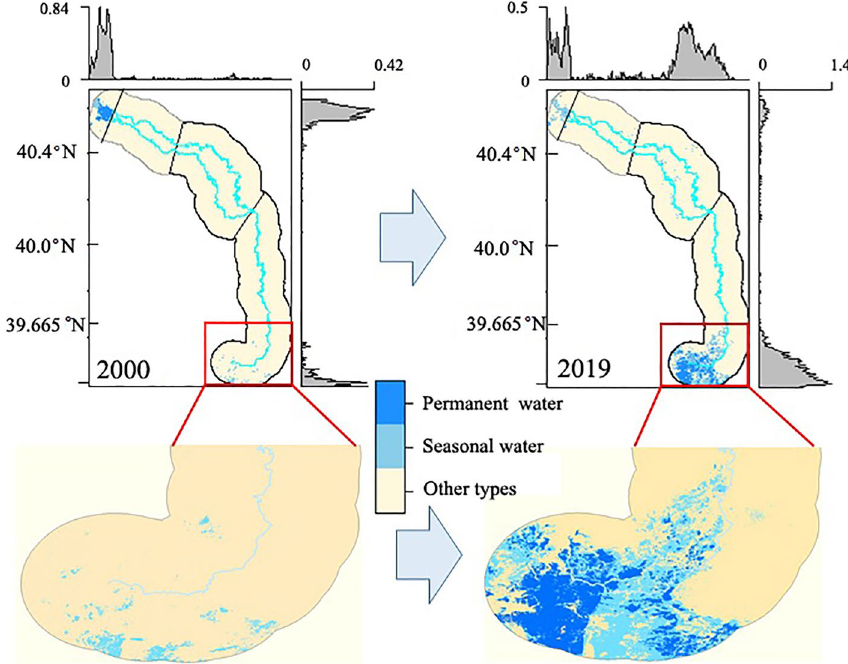
Figure 2. Spatial distribution of water surface area in lower reaches of Tarim River in 2000 and 2019. The subfigures were generated in R 4.0.2 (https:// cran.r- proje ct. org/ bin/ windo ws/), and then merged in Microsoft PowerPoint 2013 (https:// www. micro soft.